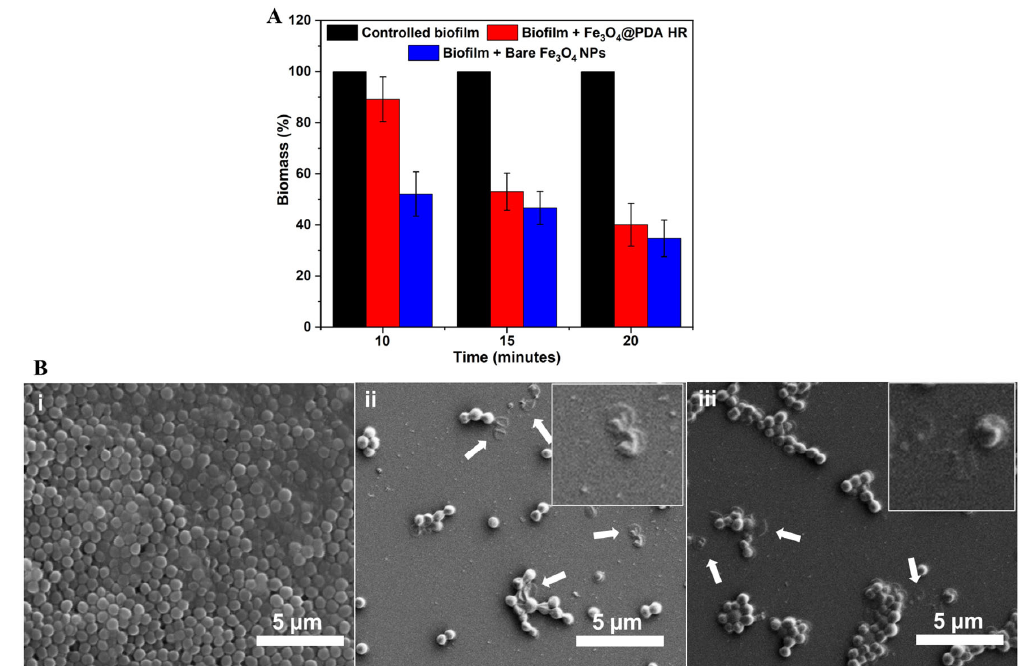
Figure 7. Reduction of pre ‐ formed biofilm biomass upon exposure to rotational magnetic field ( A ), and SEM images of pre ‐ formed biofilm upon exposure to rotational magnetic field ( B ): biofilm only ( i ), biofilm with added Fe 3 O 4 NPs ( ii ) and biofilm with added Fe 3 O 4 @PDA HR ( iii ).